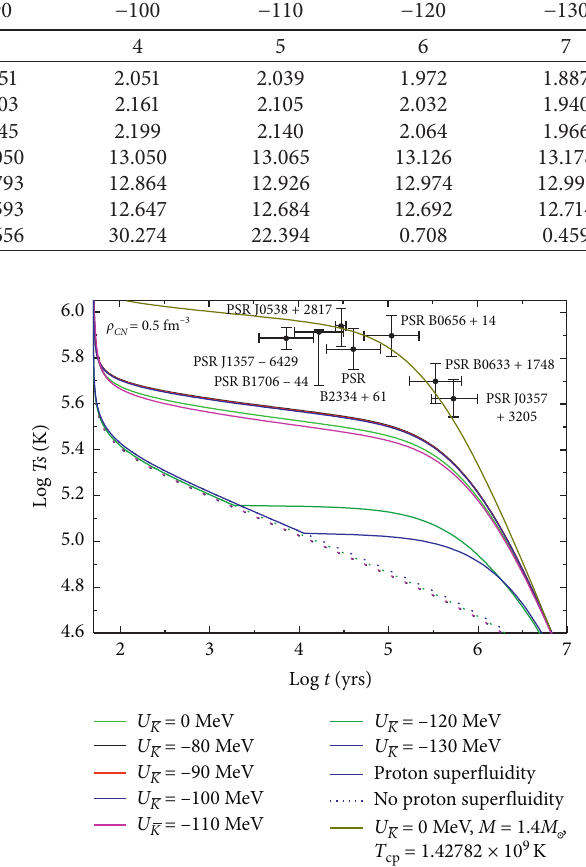
star ⊙ and J0357+3205 [45] compared with the cooling curves including the superfluids models in cores of NSs. Thick line is for the protonic 1 S 0 � 1.428K and without cooling of a superfluid 1.4 M star with T ⊙ cp K − and K 0 condensed phases.